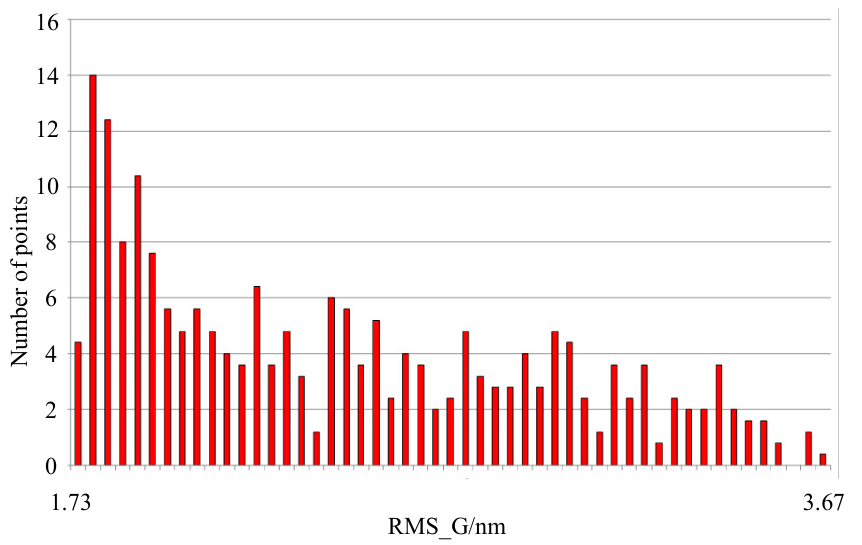
Figure 8. Probability distribution of the RMS obtained by the Monte Carlo simulation.